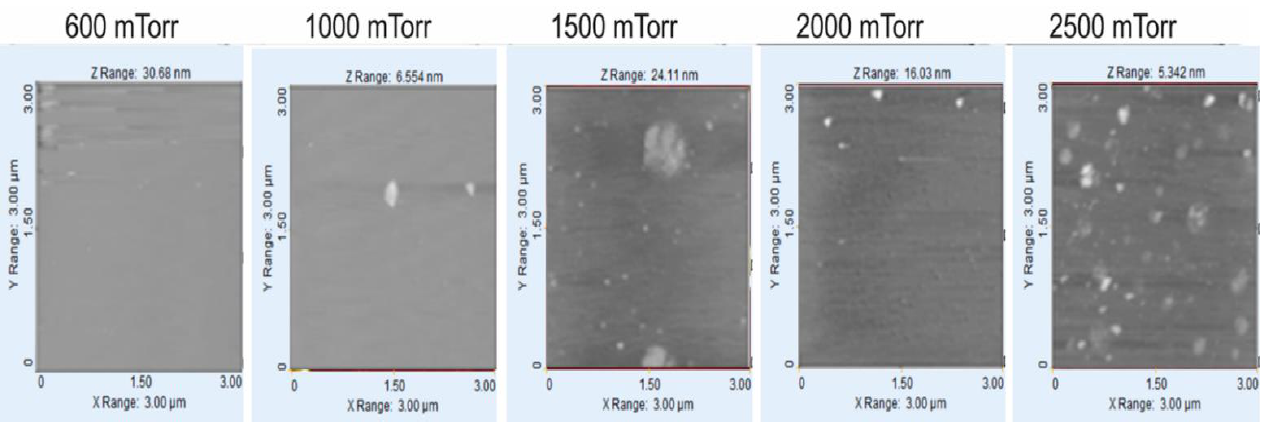
Figure 6. Images of surface of a-Si:H films deposited over glass substrate with flows of H 2 = 1000 sccm and SiH 4 = 50 sccm.